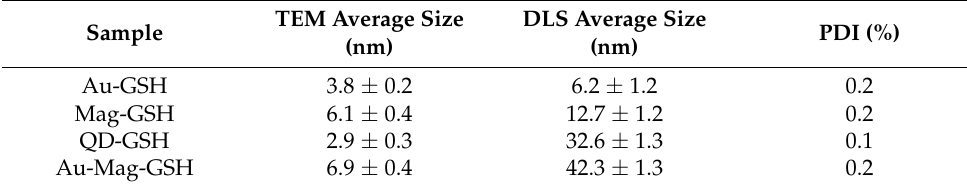
Figure 2. High-angle annular dark field (HAADF) image ( a ), as well as the histogram displaying particle size distribution ( b ) of Au-GSH NPs. ( c ) UV-Visible absorption spectrum and PL emission spectrum ( d ) of Au-GSH NPs. The inset in Figure 2c shows a digital photo image of an Au-GSH colloidal solution. Table 1. Average diameter obtained via transmission electron microscopy (TEM), dynamic light scattering (DLS) hydrodynamic diameter and polydispersity index